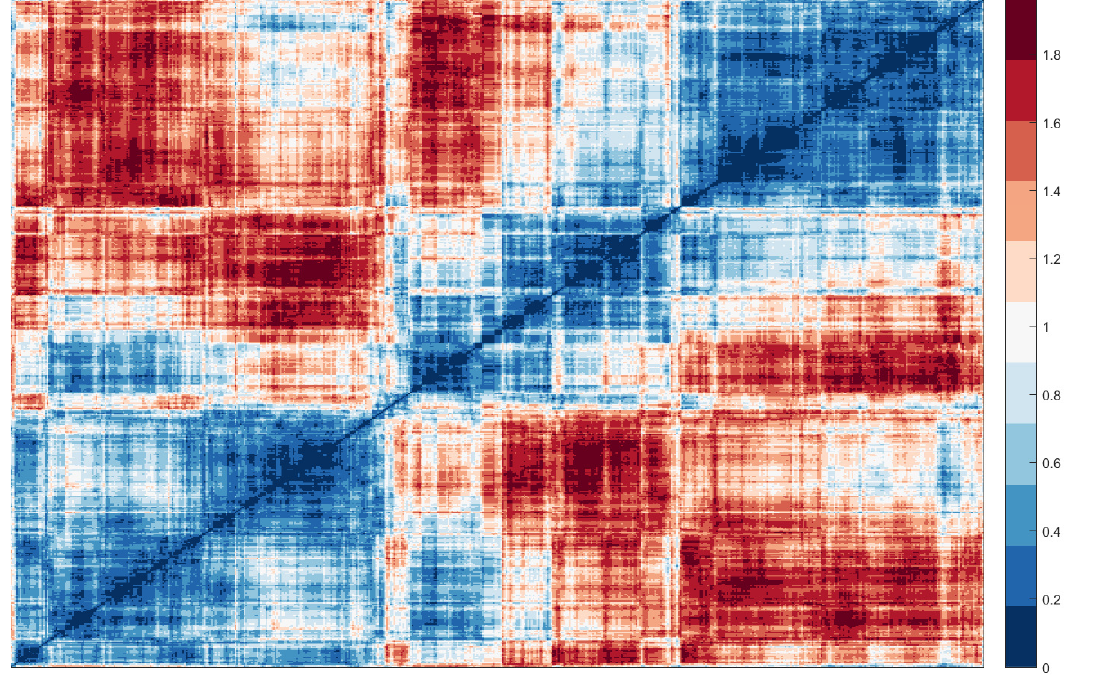
Figure 11. Spearman’s rank correlation-based clustering of 539 unique HENs. The clusters of HENs can be easily detected. The method ordered the networks according to their similarities which were mainly determined by the complexity and the applied design